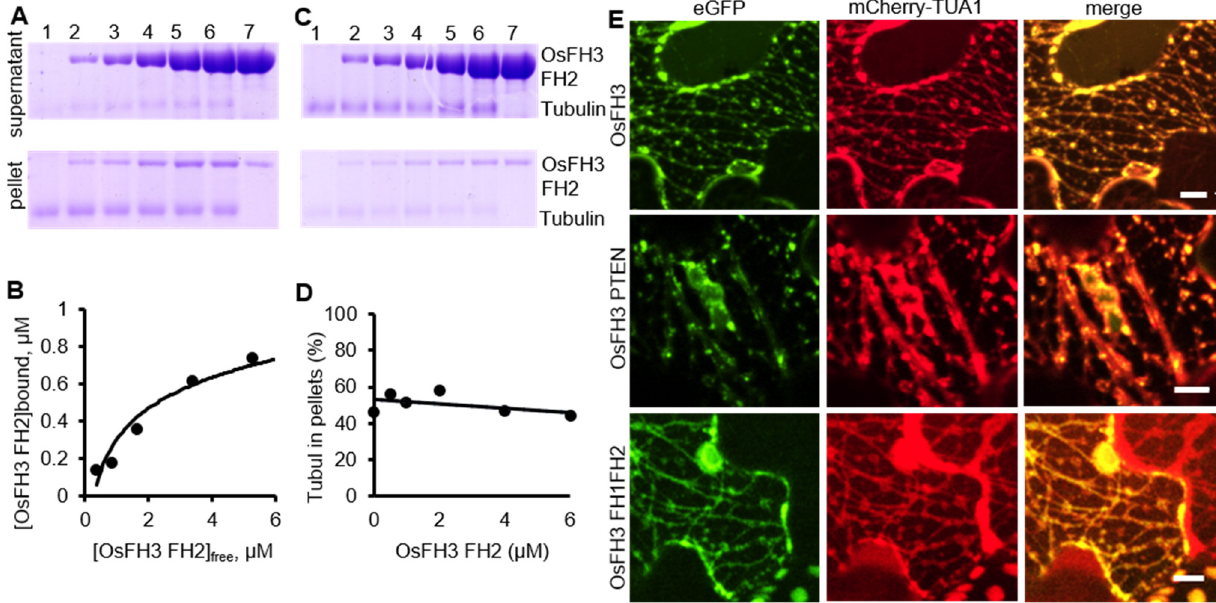
Figure 7. OsFH3 binds and colocalizes with microtubules. ( A ) High-speed co-sedimentation assays to determine tubulin binding to OsFH3 FH2. Lanes 1–6, 2 µM microtubule with 0.5, 1, 2, 4, and 6 µM OsFH3 FH2, respectively; lane 7, 6 µM OsFH3 FH2, no tubulin. ( B ) Graph shows quantification of Coomassie staining on protein gel (A). ( C ) Low-speed co-sedimentation assays to determine tubulin bundling with OsFH3 FH2. Lanes 1–6, 2 µM tubulin with 0.5, 1, 2, 4, and 6 µM OsFH3 FH2, respectively; lane 7, 6 µM OsFH3 FH2, no tubulin. ( D ) Graph shows quantification of Coomassie staining on protein gel (C). ( E ) Colocalization of OsFH3-eGFP full-length protein, PTEN, and FH1–FH2 domains with microtubule marker mCherry-TUA1 in tobacco leaves. Bar = 5 µm.